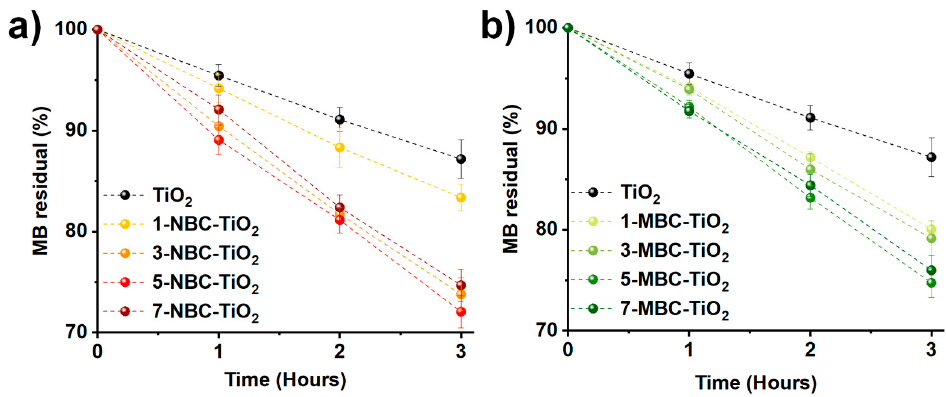
Figure 8. Effect of BC loading on the degradation of MB by nutshell—( a ) and microalgae—( b ) derived photocatalysts.